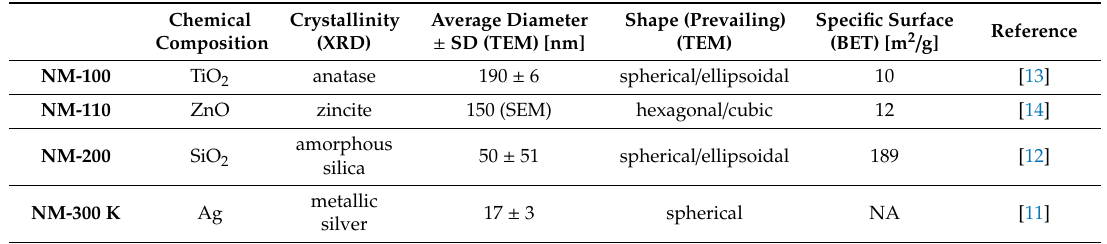
Table 2. Nanomaterial (NM) characteristics (as provided by the supplier).